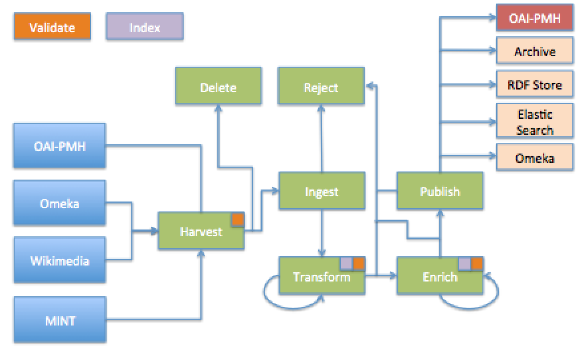
Figure 2. Aggregation workflow